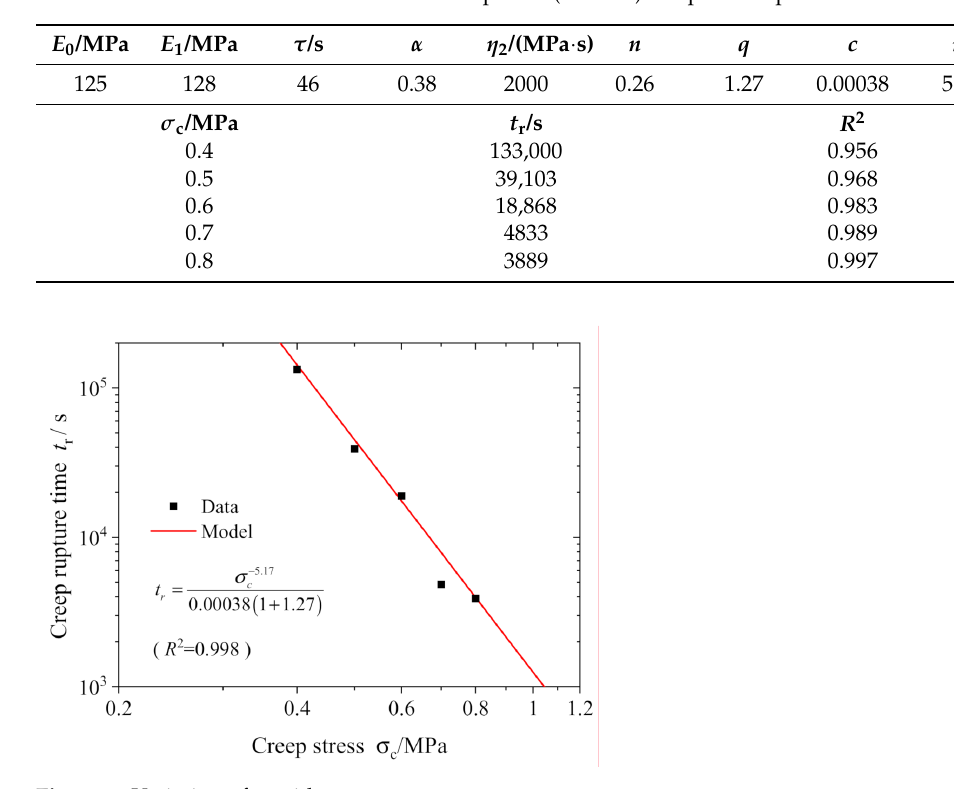
Figure 6. Isochronous stress–strain curves. Table 3. The nonlinear fractional viscoelastic plastic (NFVEP) creep model parameters.